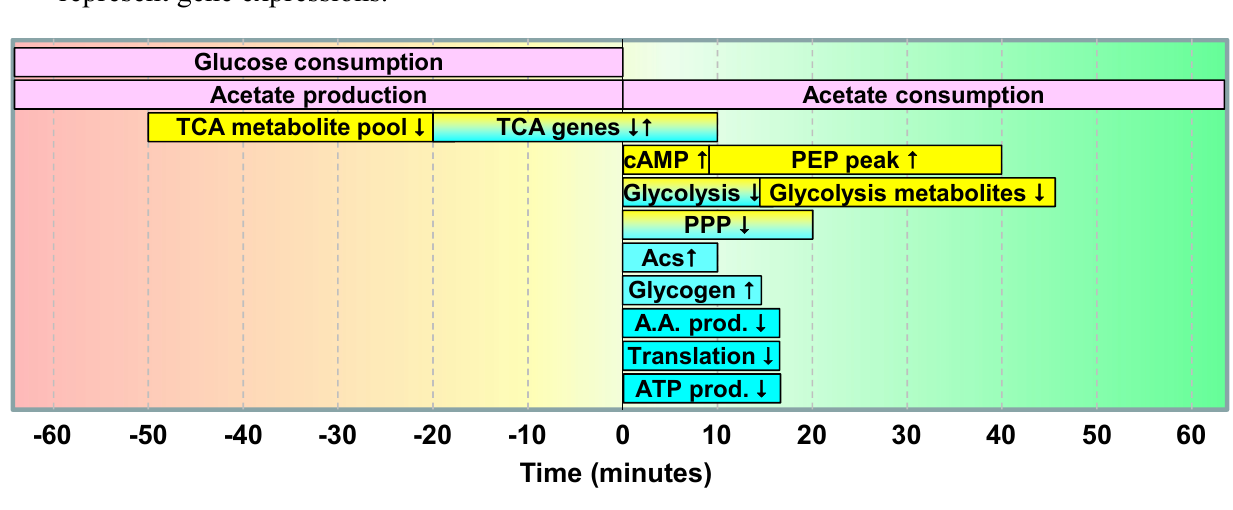
Figure 6. Timing of the glucose/acetate transition. Pink boxes represent extracellular metabolite variations, Yellow boxes represent metabolite concentrations and blue boxes represent gene